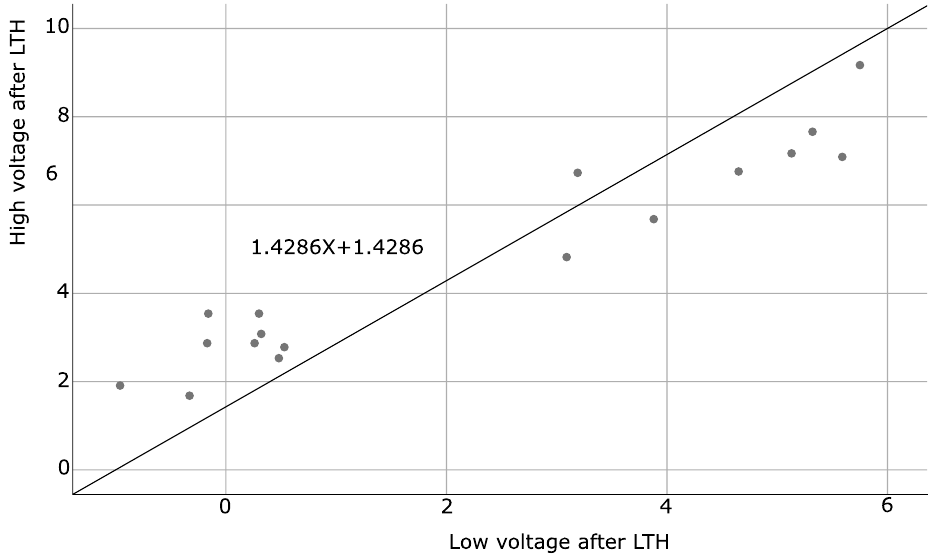
Figure 8. Illustrates the correlation between low and high voltage values measured after LTH of SA